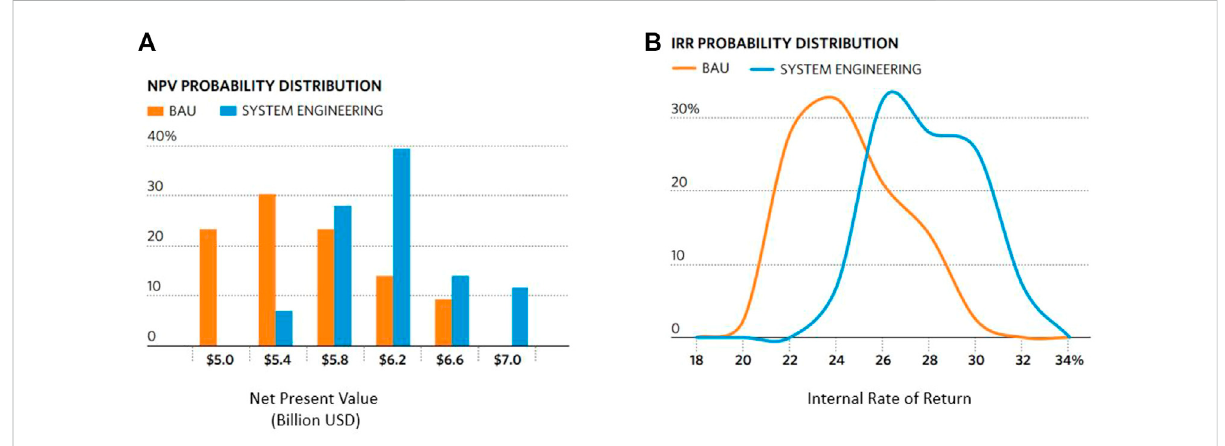
FIGURE 8 Distribution of Net Present Value (NPV); (A) and Internal Rate of Return (IRR); (B) for BAU vs. system engineering scenarios for hydropower developmentinColombia ’ sMagdalena basin.Both fi gures showvalues oftheaggregatedcash fl owsfromallprojects inascenario, withdistributions of values re fl ecting 50 simulations of cash fl ows for each